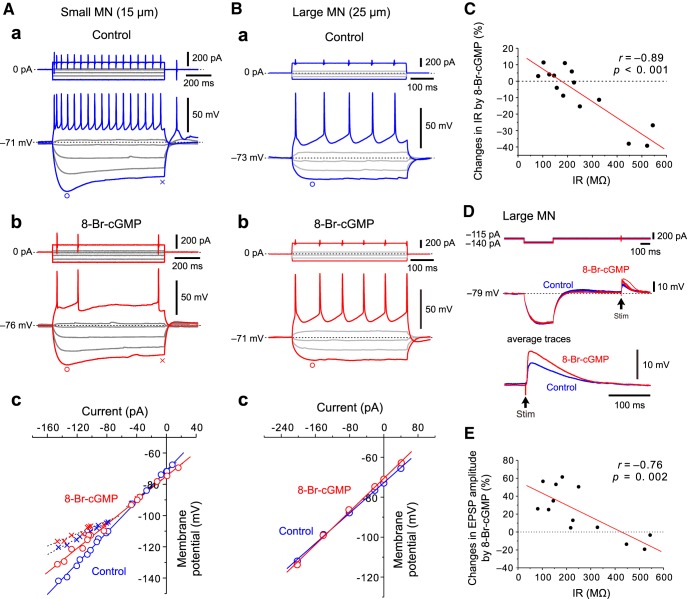
Modulation of IRs by 8-Br-cGMP in small and large MNs in the dl-TMN. Aa, Ab, Sample traces of responses to depolarizing and hyperpolarizing current pulses obtained before application (Aa) and during application (Ab) of 8-Br-cGMP in a small MN. Ac, The I–V relationships obtained before and during application of 8-Br-cGMP in a small MN. The I–V relationships measured at the peak sag potentials are almost linear (blue and red circles), while those measured just before the offset of current pulses are inwardly rectifying (blue and red crosses). Ba, Bb, Sample traces of responses to depolarizing and hyperpolarizing current pulses obtained before application (Ba) and during application (Bb) of 8-Br-cGMP in a large MN. Bc. The I–V relationships obtained before and during the application of 8-Br-cGMP in a large MN. C, The relationship between IRs of MNs and changes in IRs by 8-Br-cGMP (n = 14). D, EPSPs evoked by stimulation just dorsal to the TMN obtained before and during the application of 8-Br-cGMP in a large MN. E, The relationship between IRs and changes in EPSP amplitudes by 8-Br-cGMP (n = 13).